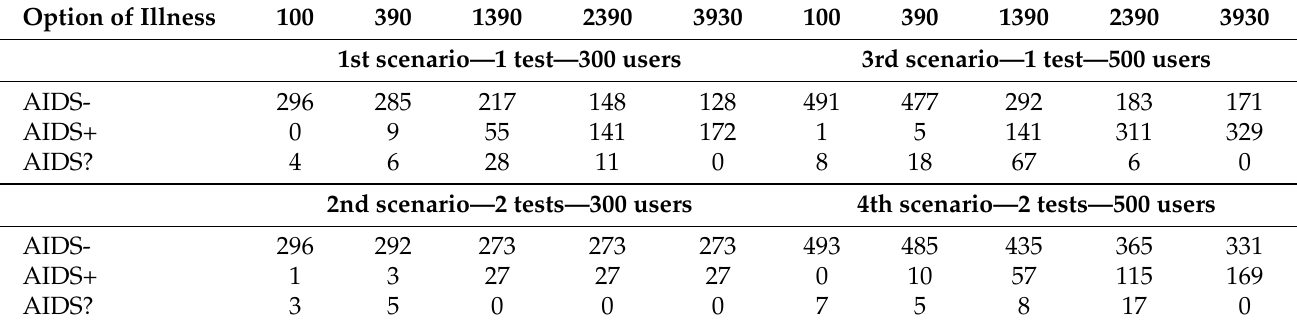
Table 9. Comparison between the four scenarios for a different number of weeks by considering the 6th example with 10%